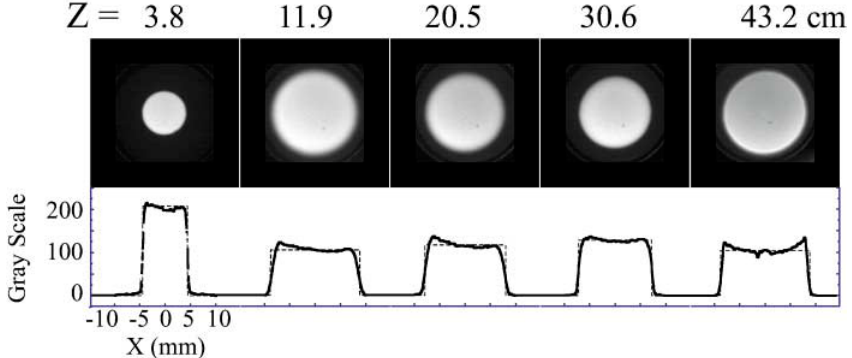
FIG. 3. (Color) Fluorescent screen pictures (top) and normalized horizontal intensity profiles (bottom) of 4 keV, 17 mA ( 5 m s) electron beam from a convergent-type gun. (See Fig. 2 for additional explanation.) for the 5 and 4 keV beams, respectively (the solenoid peak fields are given above). Thus, taking the plane of the apertures as the object plane ( z (cid:1) 0 ), the paraxial images occur at z 1 (cid:1) 24.1 cm and z 2 (cid:1) 23.4 cm, instead of the observed 29 and 43.2 cm for the rings.